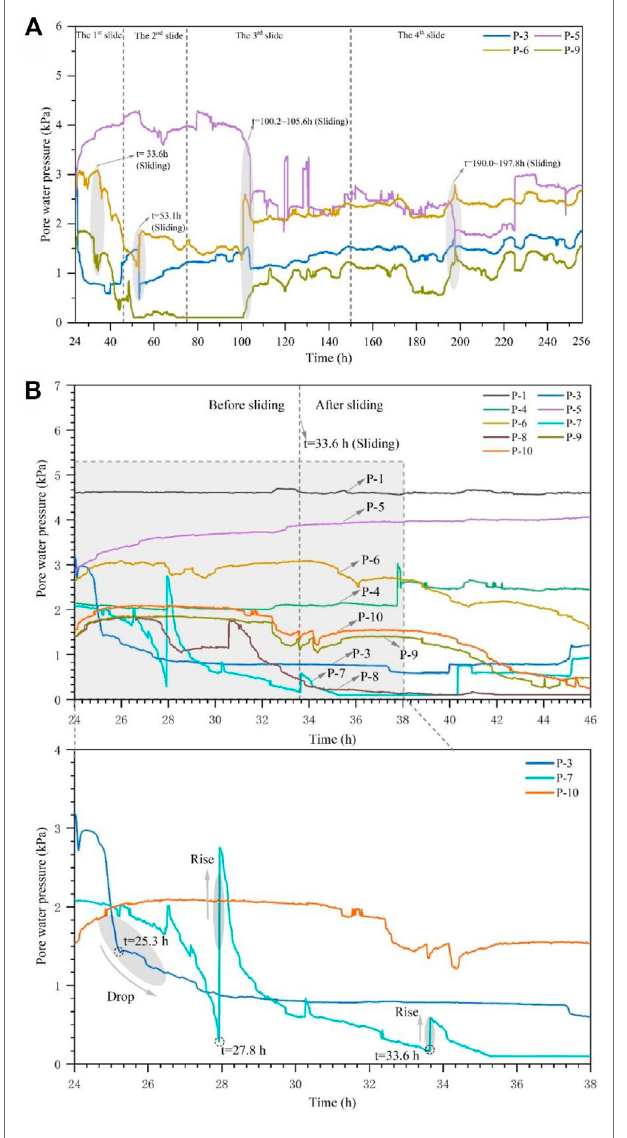
FIGURE 10 | Variation of pore water pressure during slope failure. (A) Pore water pressure during thewholesliding, (B) pore waterpressuresduring the 1st slide, (C) pore water pressure during the 2nd slide, (D) pore water pressure during the 3rd slide, and (E) pore water pressure during the 4th